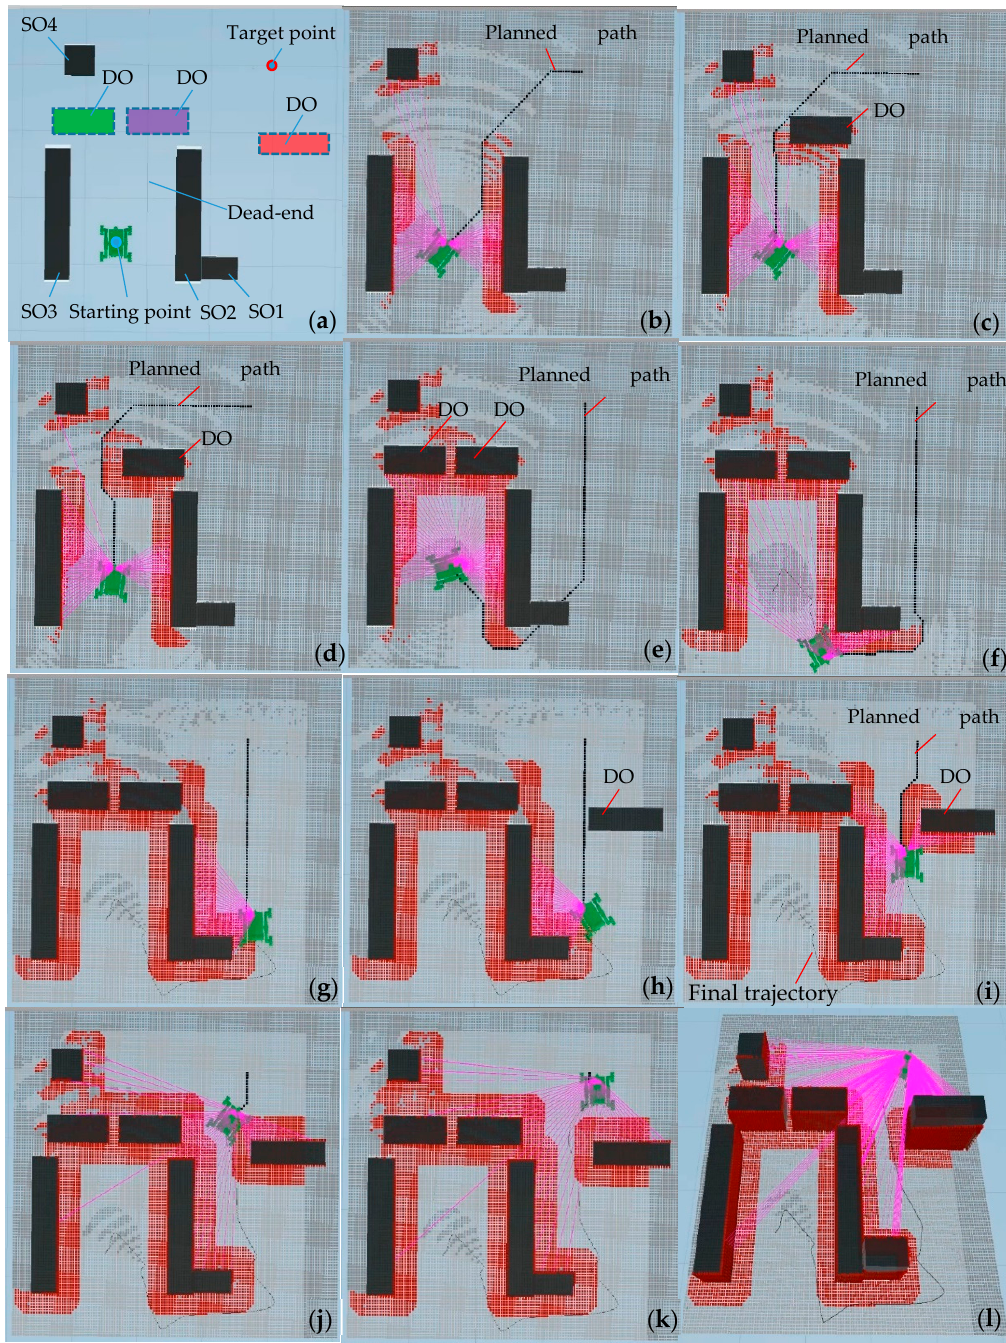
Figure 37. Navigation simulation of the robot in the dynamic environment: ( a ) a dynamic environment consisting of a flat ground, static obstacles (SO), and dynamic obstacles (DO); ( b ) path planning for the environment with static obstacles; ( c – d ) path planning after dynamic obstacle DO1 was added; ( e – g ) path planning after dynamic obstacles DO1 and DO2 were added; ( h ) the moment when dynamic obstacle DO3 was added; ( i – k ) path planning after dynamic obstacle DO3 was added; ( l ) robot arrives at the target